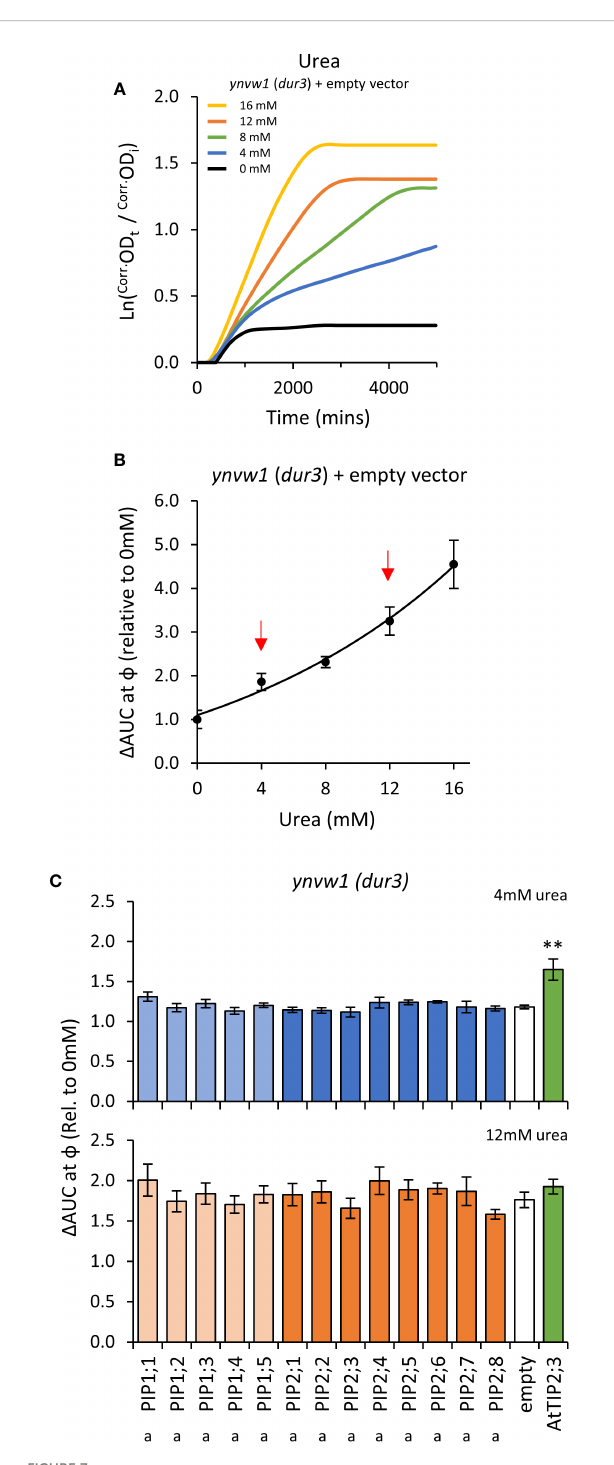
FIGURE 7 Urea permeability assays. (A) , Growth curves of ynvw1 ( dur3 ) yeast supplied with increasing concentrations of urea. (B) , Relative AUC as a function of urea concentration. Red arrows denote urea concentrations chosen for testing yeast expressing AtPIP . (C) , Relative AUC for yeast expressing each AtPIP grown with 4 or 12mM urea, with AtTIP2;3 as a urea permeable control. All error bars are SEM. For (C) , asterisks indicate statistical difference from empty vector control, ANOVA with Fishers LSD test (** P < 0.01); letters denote statistical rankings across both 4 and 12mM urea, ANOVA with Tukey ’ s test ( P < 0.05). For C, N = 6 across 3 experimental